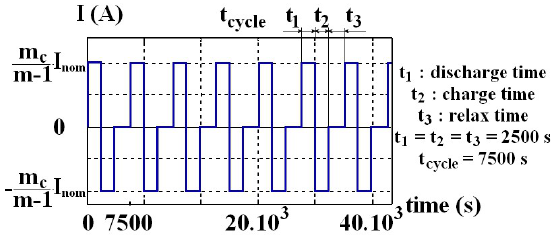
Figure 9. Current profile during a simulation cycle.